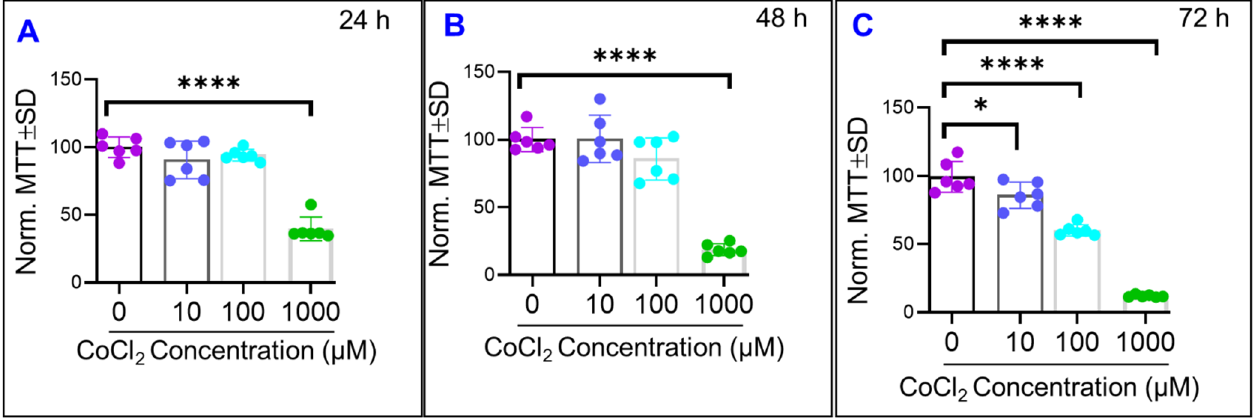
Figure 8. Effects of cytopathic hypoxia on ARPE-19 cell viability. MTT assays were performed on our control and treatment groups at 3 discrete time points in the experiment. ( A ) MTT response of each group at 24 h after treatment application. Only the 1000 µM of CoCl 2 and the control group are different from each other at this time. ( B ) MTT response at 48 h after treatment, again where only the 1000 µM CoCl 2 group and control are different from each other. ( C ) MTT response at 72 h post treatment, where each treatment group now demonstrates a significant difference when compared to control group. Data shown are the mean ± SD of 6 independent biological replicates ( n = 6/group); p values are * p ≤ 0.05 and **** p ≤ 0.0001.